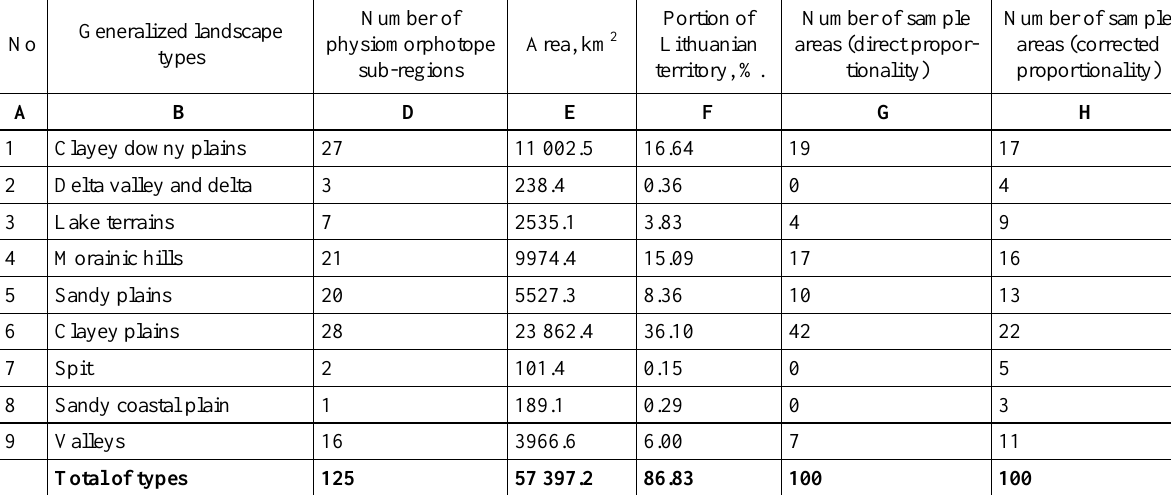
Table 1. Distribution of the number of sample areas according to the main landscape types Generalized No